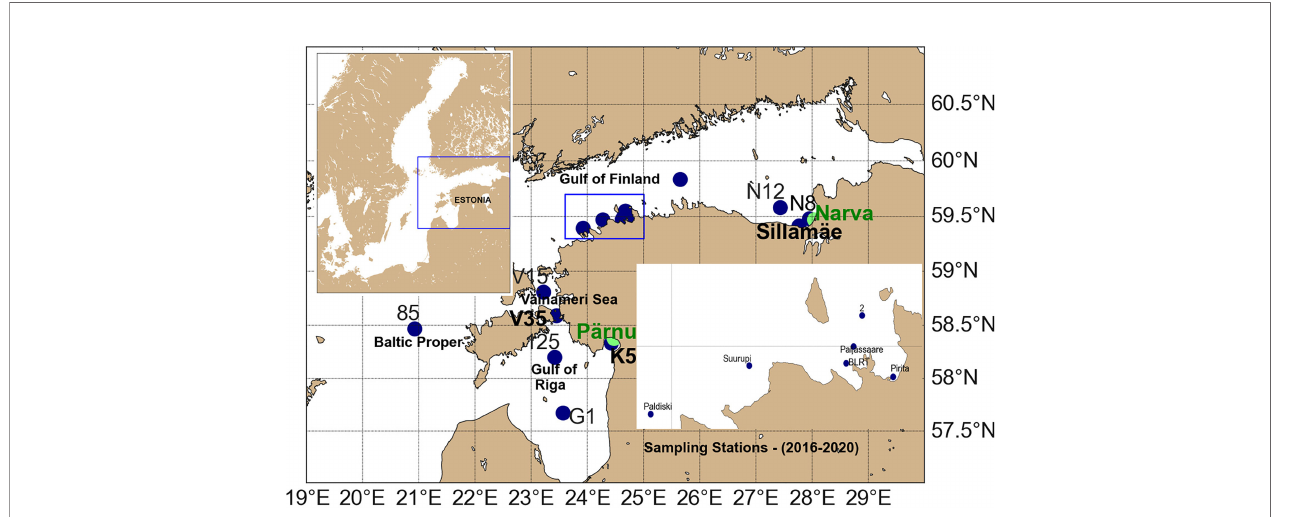
FIGURE 1 | Map of the eastern Baltic Sea with 16 stations of surface water sampling in the BP region (85), GOR (G1, K5, and 125), VS (V15 and V35), GOFW (Paldiski, Suurupi, BLRT, Paljassaare, and Pirita), GOFC (14), and GOFE (N12, Sillamäe, and N8). The locations of Narva and Pärnu river are highlighted in